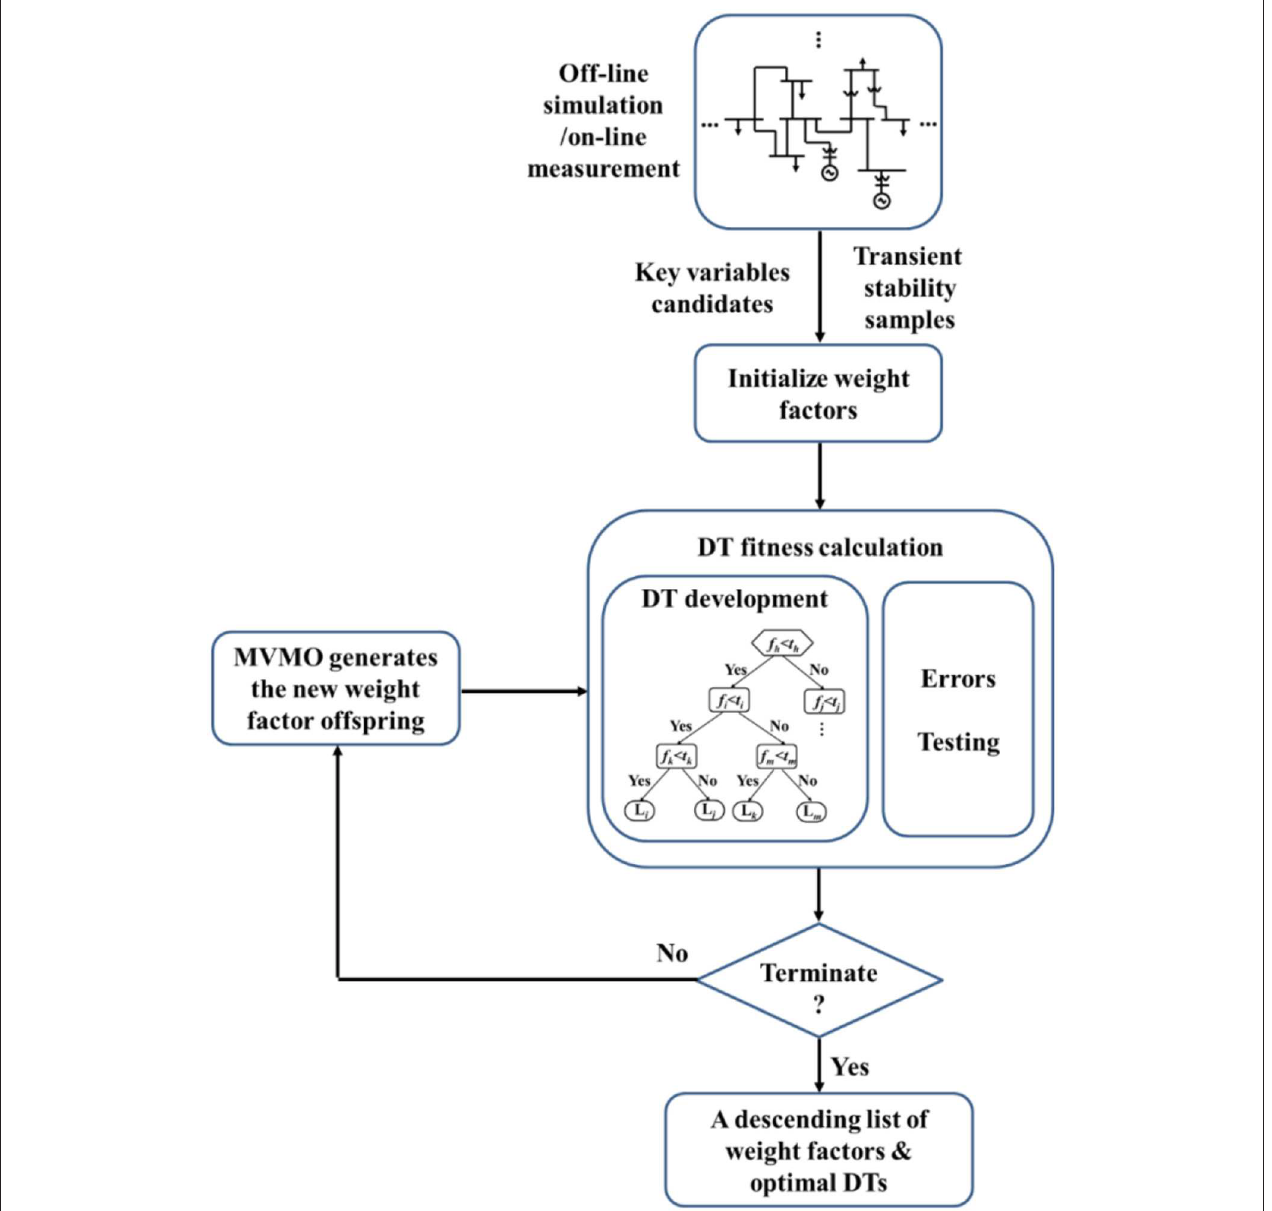
FIGURE 4 | Key variables selection jointly using DTs and